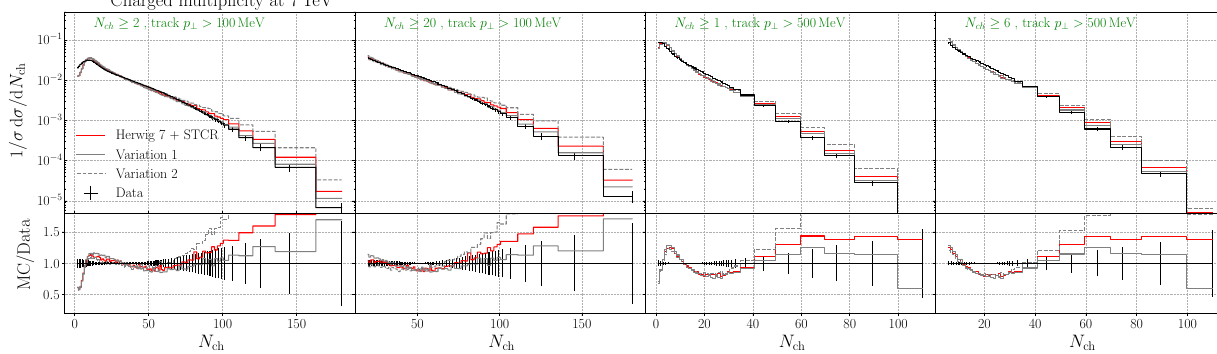
Fig. 9 Charged particle spectrum against rapidity and transverse momentum for various leading track p ⊥ and number of charged particle N ch slices. An overall good agreement with data is found. The variation